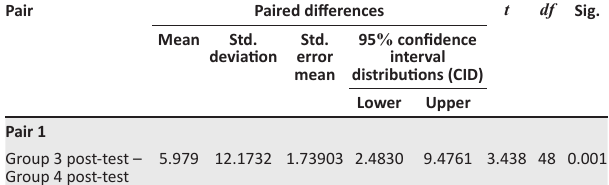
TABLE 4: Paired samples test: Solution with the two group control group design. Pair Paired differences t df Sig. Mean Std. Std. error deviation mean